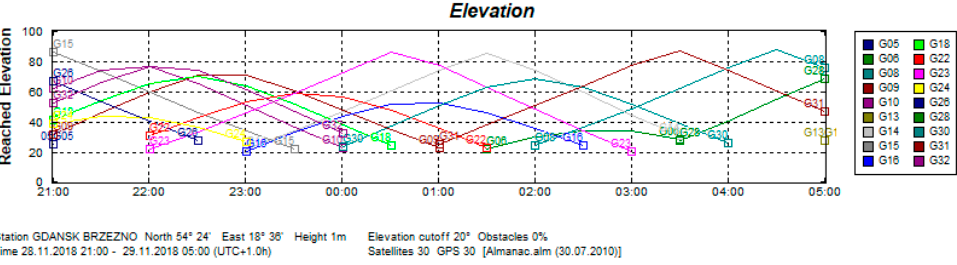
Figure 18. GPS satellite elevations on 28,29 November 2018. ( Source : Trimble Planning 2.9, 2010) The satellite compass requires a signal from at least five satellites for each antenna to determine vehicle heading. Based on Figure 19, it can be seen that a condition of a visibility of at least five satellites to quantify the heading of the vehicle with the arbitrarily assumption of the elevation cut- off at 20 degrees has been met during the experiment.